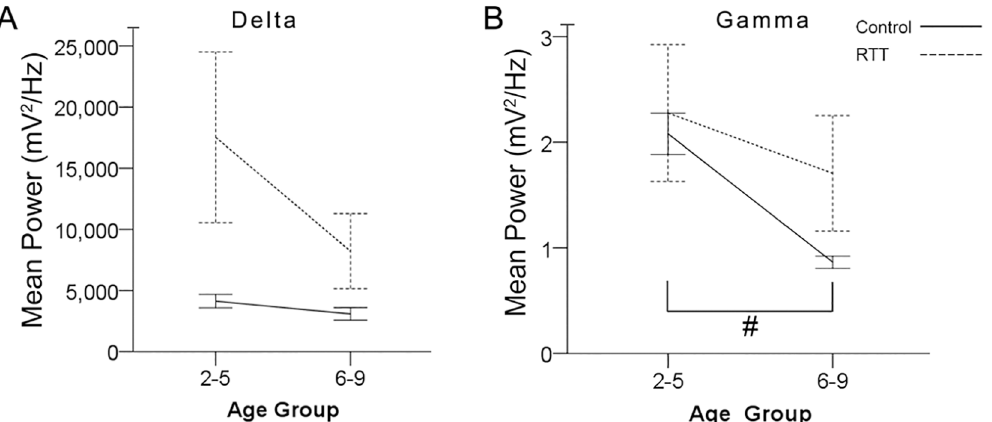
Fig 3. Age-dependent evolution. Because occipital lead displayed the greater difference between genotypes, occipital line graphs were used to display age related comparison. (A) Comparison of delta power revealed no significant difference between ages. Difference in delta power between Control EEGs and RTT EEGs seems to be driven by 2 – 5 year age group. (B) Gamma power in control group had a significant decrease from age group 2 – 5 year to 6 – 9 year group. The sharp decrease in gamma power is lost in patients with RTT as age increases.